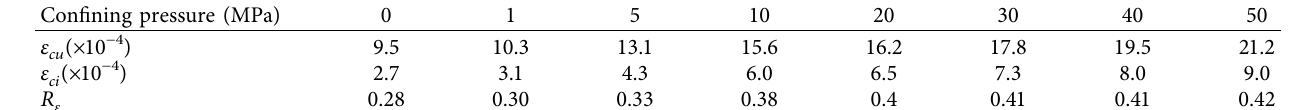
R under different confining pressures. ci , ε cu , and ε